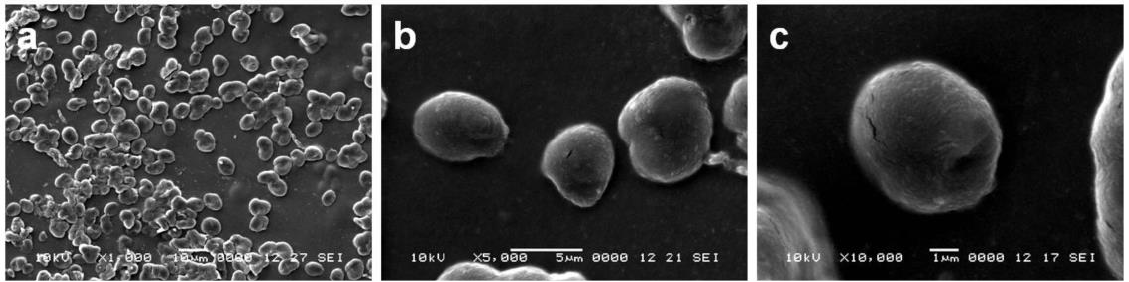
Figure 2. Sintered c.p. Ti sample: ( a ) general aspect (optical microscopy), unetched sample; ( b ) details on the shape of pores (SEM).